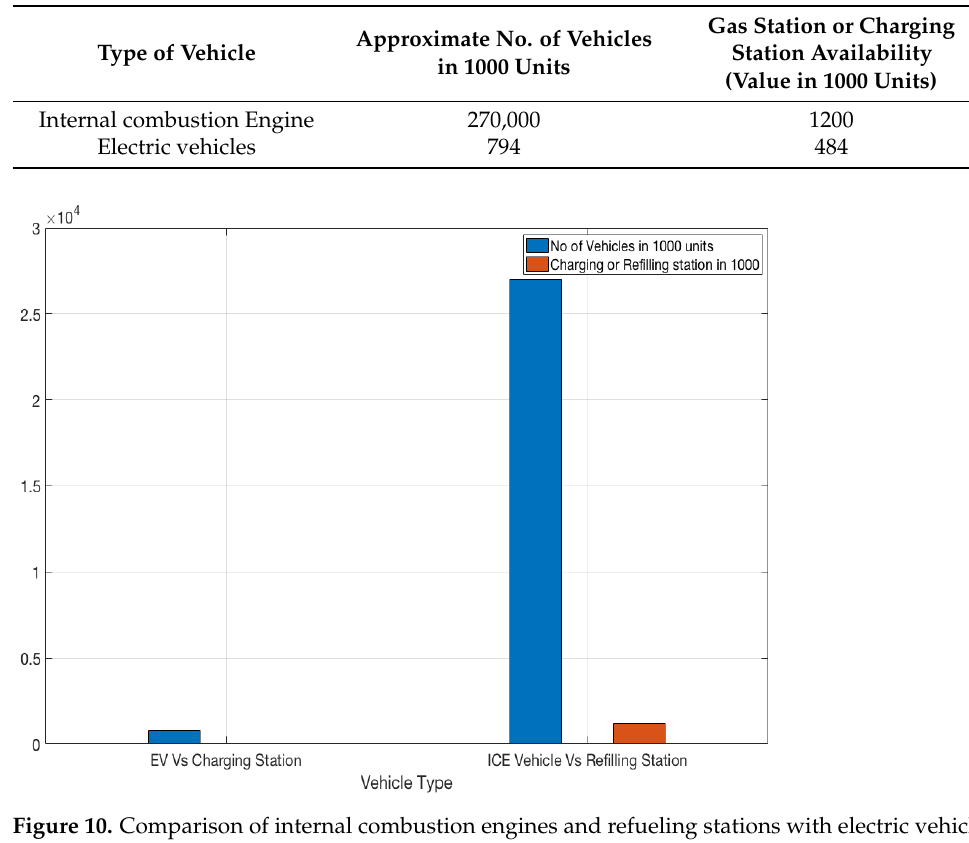
Table 5. Charging and refueling stations.